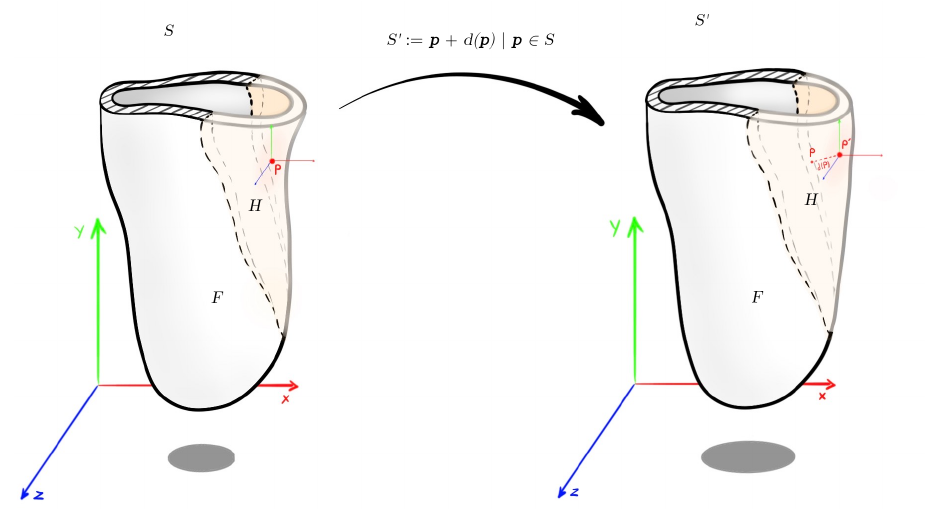
Figure 7. Socket deformation with the mathematical notation used.